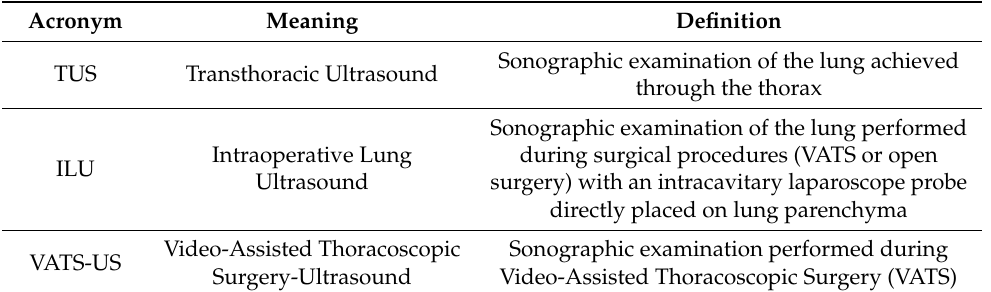
Table 1. Table of nomenclature of the different sonographic approaches to the lung parenchyma. Acronym Meaning Definition Sonographic examination of the lung achieved TUS Transthoracic Ultrasound through the thorax Sonographic examination of the lung performed Intraoperative Lung during surgical procedures (VATS or open ILU Ultrasound surgery) with an intracavitary laparoscope probe directly placed on lung parenchyma Video-Assisted Thoracoscopic Sonographic examination performed during VATS-US Surgery-Ultrasound Video-Assisted Thoracoscopic Surgery